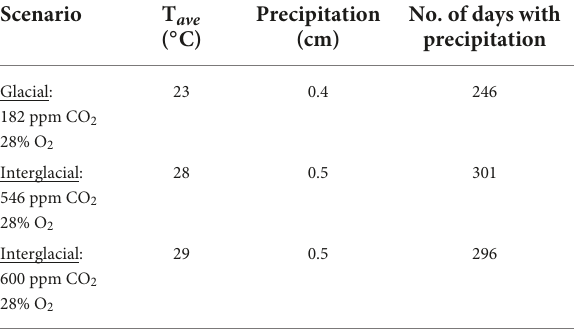
TABLE 3 Summary of the meteorological input scenarios to Paleo -BGC and Paleo